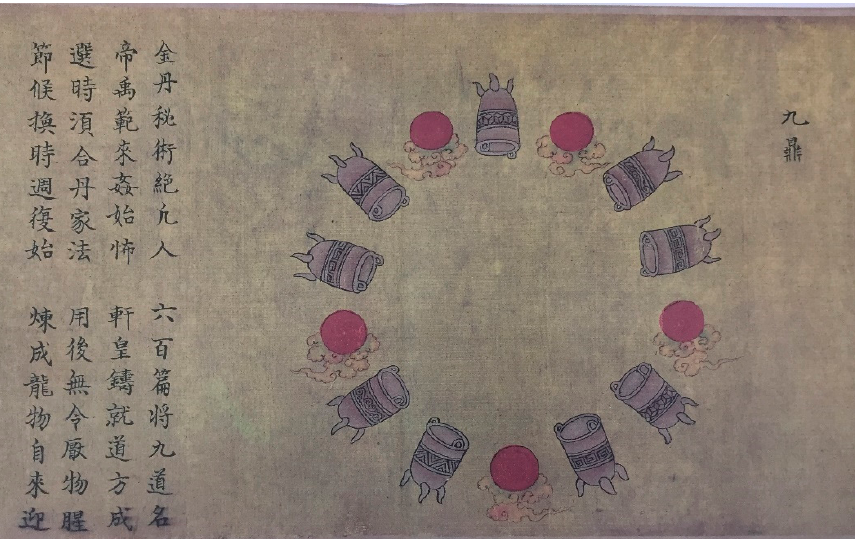
Figure 13. Diagram of the nine tripods, Jinye huandan yinzheng tu, colored scroll version, collected by Baiyun Daoist Monastery of Beijing.